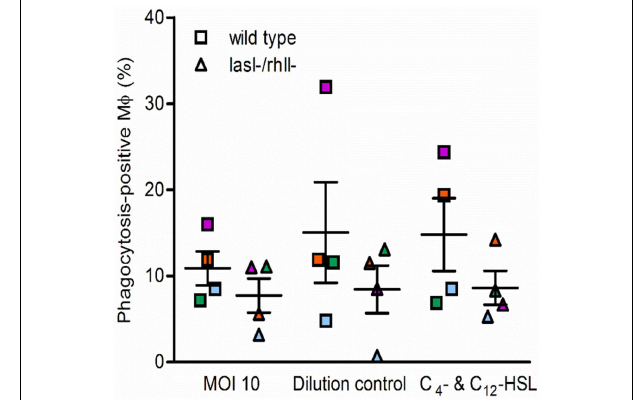
FIGURE 2 | Functional complementation of phagocytosis with AHL. Macrophages were pretreated with 25 µ M C 4 -HSL and 50 µ M 3O-C 12 -HSL (C 4 - C 12 -HSL), or 0.02% DMSO as a vehicle control (Dilution control), or not-pretreated (MOI 10) for 4h before 1-h infection with P. aeruginosa wild type or lasI-/rhlI- mutant, at MOI 10. Quantification of phagocytosis presented as the percentage of phagocytic-positive (containing ingested bacteria) cells among total macrophages. Shown are mean ± SE of four independent experiments performed at separate days from four different donors (color coded). The means ± SE are based on 100–200 cells for each condition per